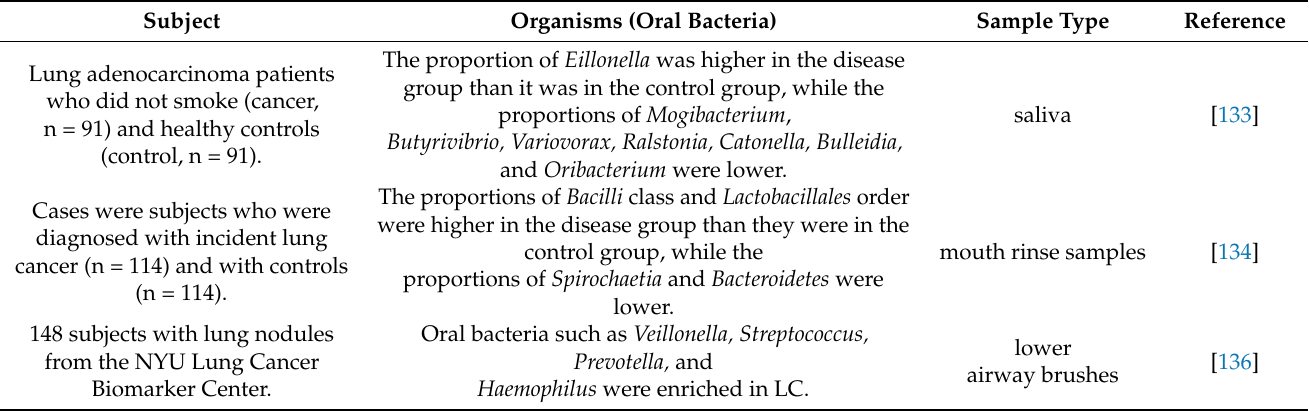
Table 5. Oral organisms associated with respiratory tumors (lung